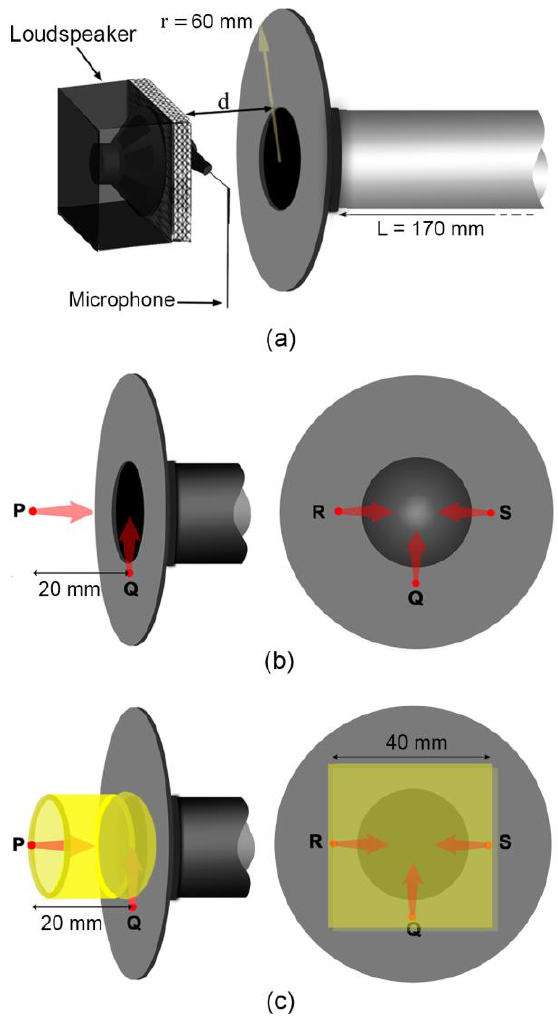
Figure 3. ( a ) Schematic showing default configuration of loudspeaker and microphone used to make gamma measurements (C1); ( b ) P, Q, R, and S indicate the locations and orientations of the loudspeaker and microphone in C1 to C5; ( c ) for C6 to C10, similar P, Q, R and S, but now with acoustic foam applied (indicated in yellow): C6, C7, and C8 utilize a hollow cylindrical foam (left) while C9 and C10 have a foam ‘cap’ filling in the space between the transducers and flange (right). Table 1. Description of the configuration setup.